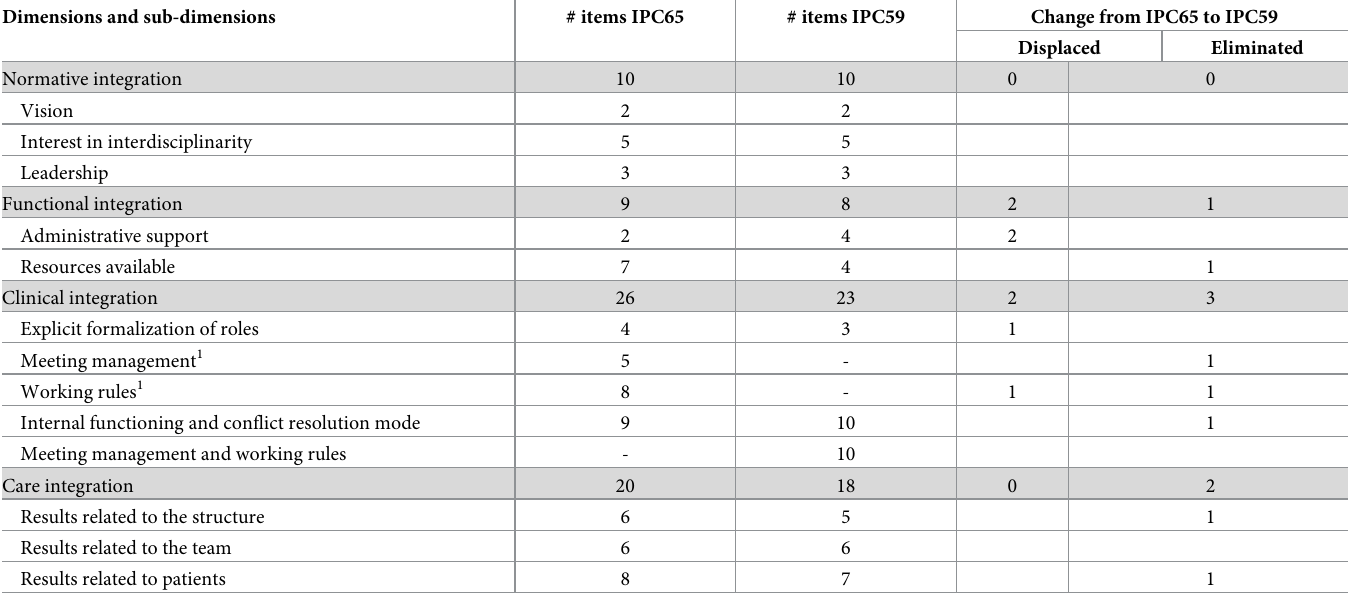
Table 1. Dimensions and sub-dimensions of IPC65 and